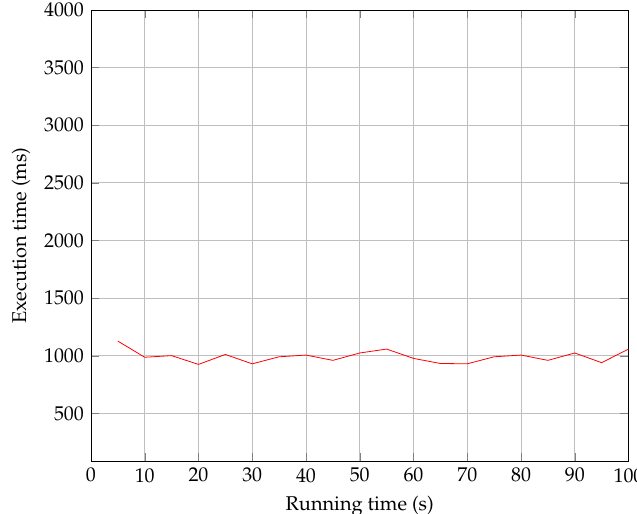
Figure 5. Computed inferring time for the Python